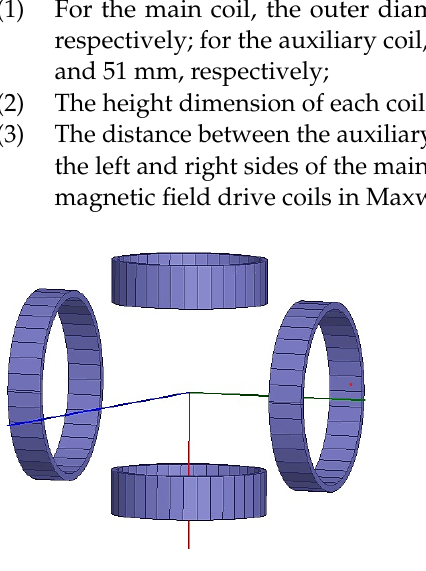
Figure 5. Simplified modeling diagram of the new magnetic field-driven coil.